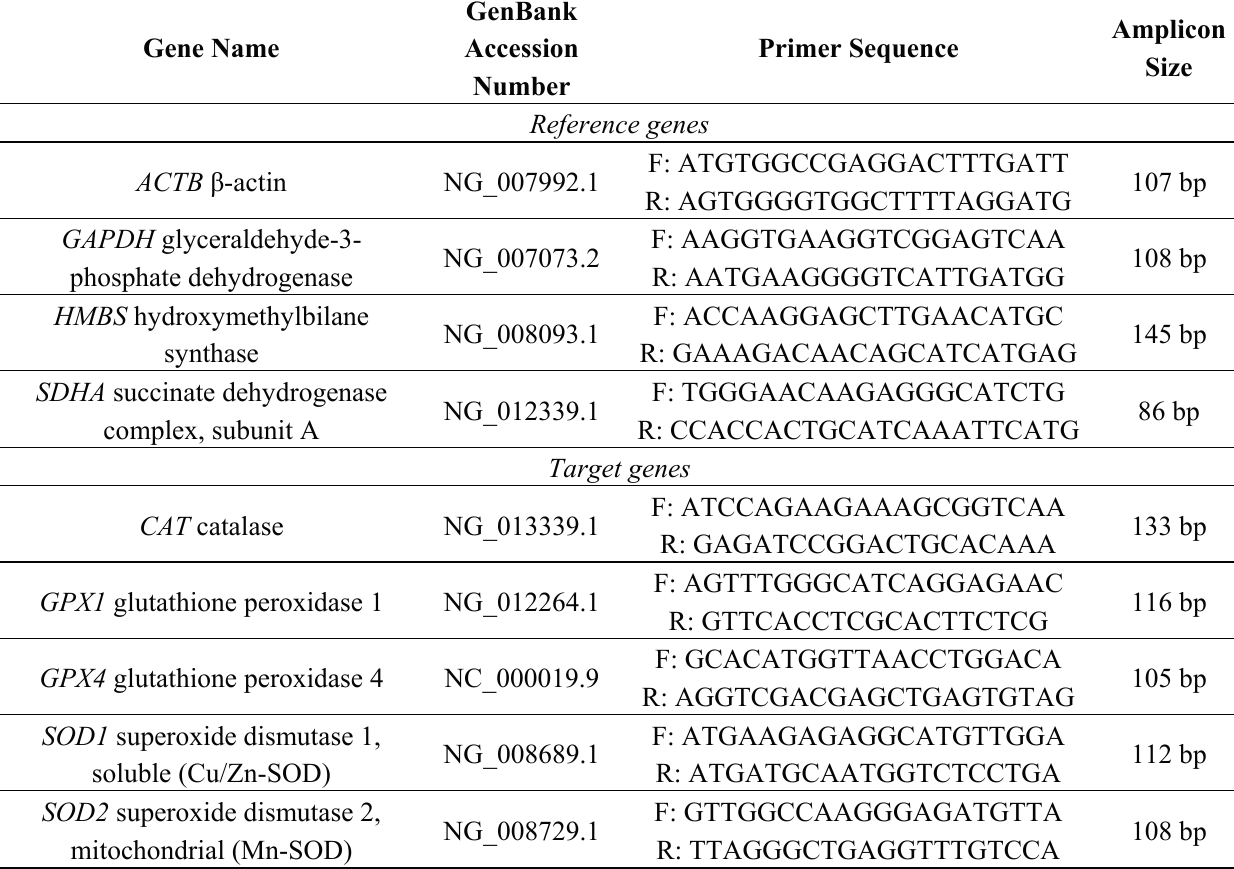
Table 2. Primer sequences for